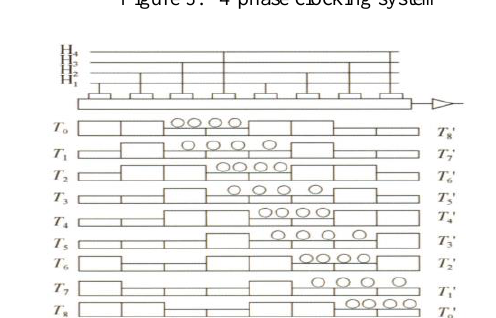
Figure 3. 4-phase clocking system